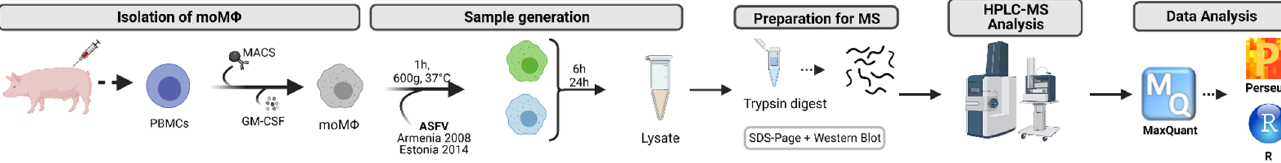
Figure 1. Representation of the proteomic workflow. Peripheral blood monocytic cells (PBMCs) are isolated, selected for CD172a+ monocytes, differentiated into monocyte-derived macrophages (moM Φ ), and infected with Armenia 2008 or Estonia 2014. Proteins are extracted at 6 and 24 hpi, digested with trypsin and analysed on a timsTOF LC-MS platform. Data analyses are carried out with MaxQuant and Perseus software or in-house R scripts.